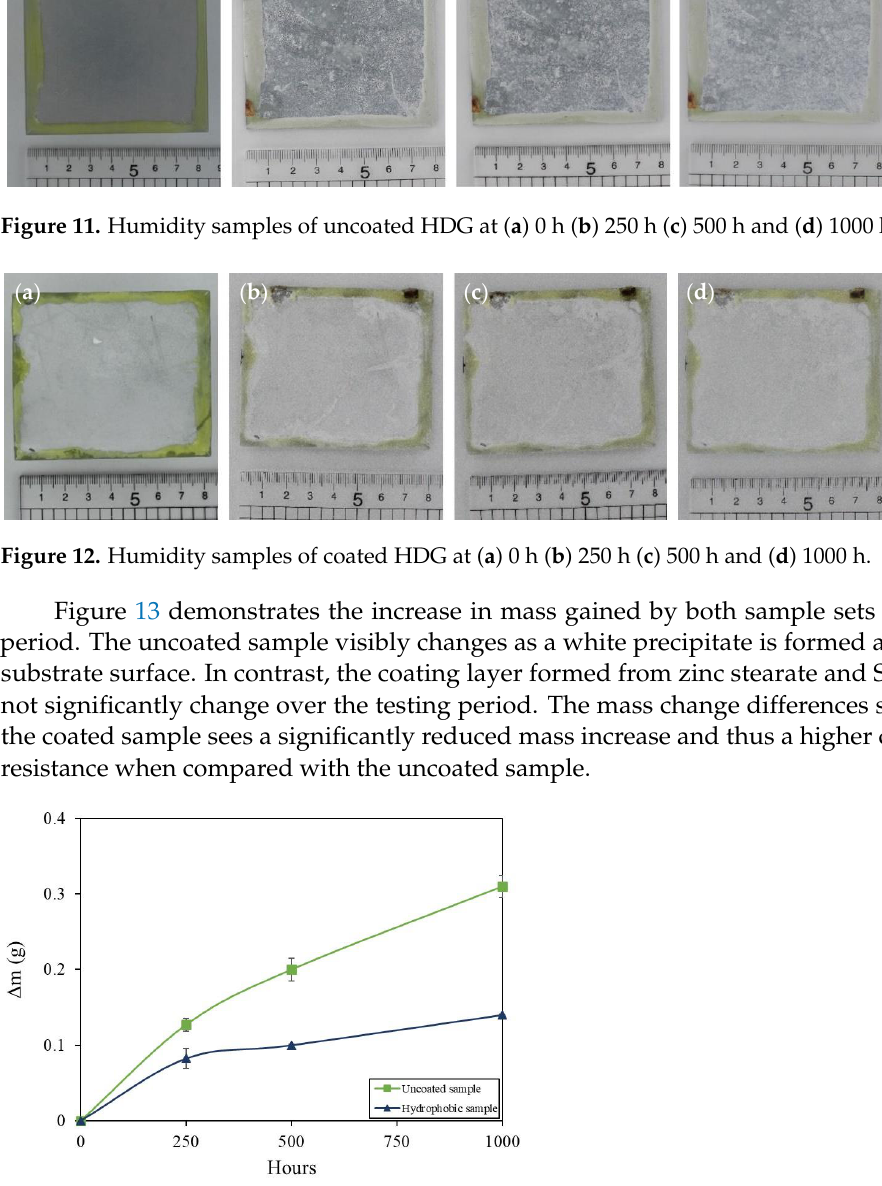
Figure 13. Mass gain of humidity samples over 1000 hours displaying uncoated sample and hydro- phobic sample. hydrophobic